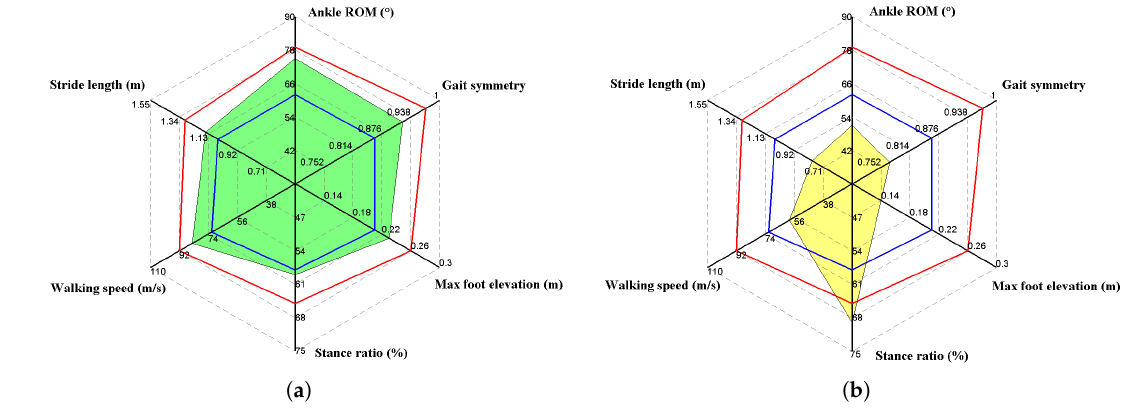
Figure 10. Gait metric comparison results, where red and blue lines represent the minimum and maximum of the corresponding gait parameters: ( a ) Healthy male, age 45 years, weight 76 kg, height 1.74 m, BMI 25.1 kg/m 2 ; ( b ) a stroke survivor, male, age 47 years, weight 69 kg, height 1.72 m, BMI 23.3 kg/m 2